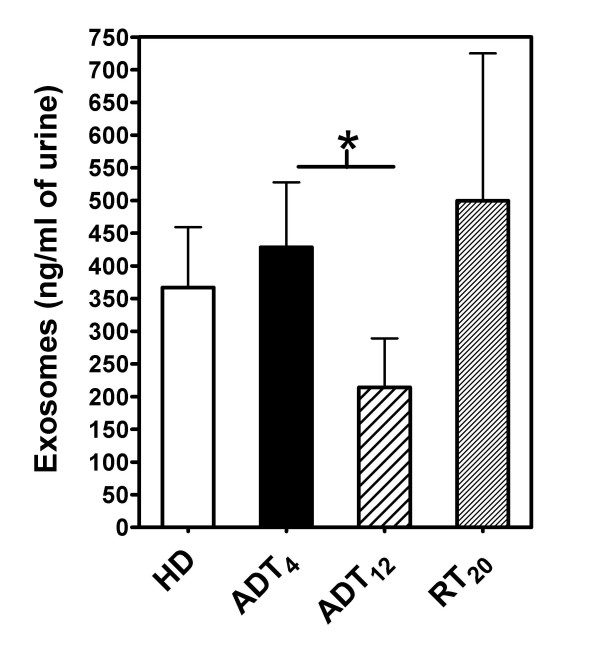
Quantification of urine-derived exosomes, in healthy donors, and Prostate Cancer patients. The quantity of exosomes present in each preparation was measured using the BCA protein assay. Values were corrected for urine-specimen volume, and are represented as ng Exosomes per ml of urine. Preparations from 10 healthy donors and 10 PCa patients undergoing standard therapy, at ADT4 (after 4 weeks ADT), ADT12 (after 3 months of ADT), and at RT20 (and after 20-fractions of radiotherapy) are compared. Bars represent mean+SE. *p < 0.5 using the Wilcoxon matched pairs test are shown.